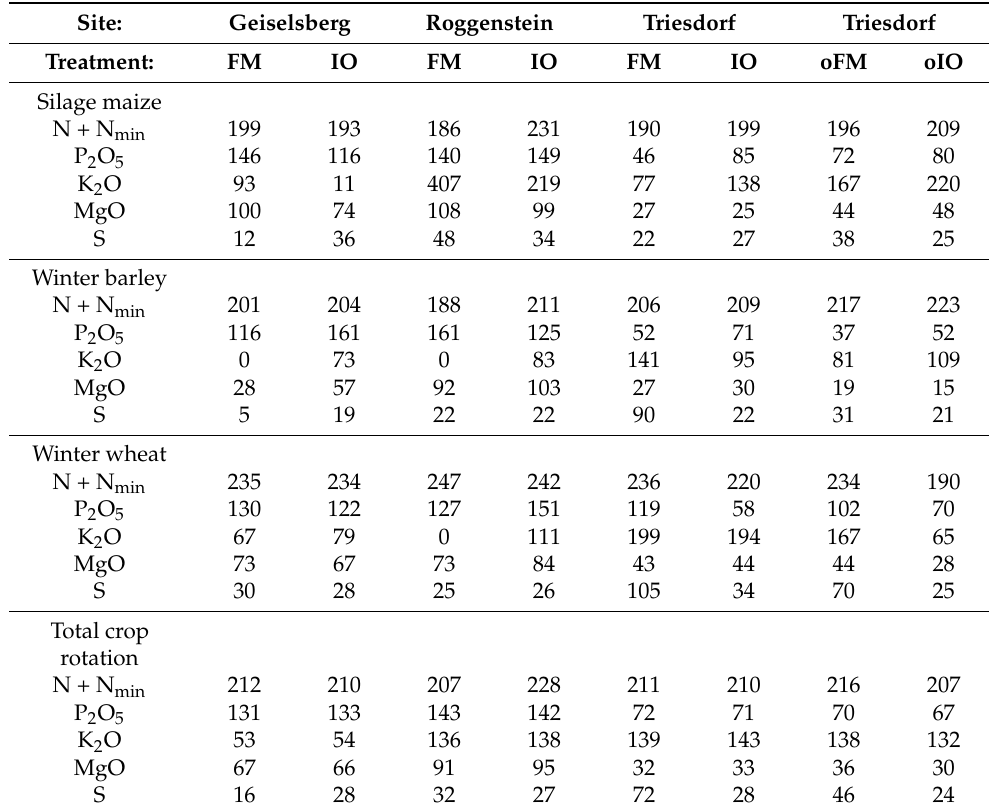
Table 2. Comparative overview of nutrient supply by location, crop, and treatment.